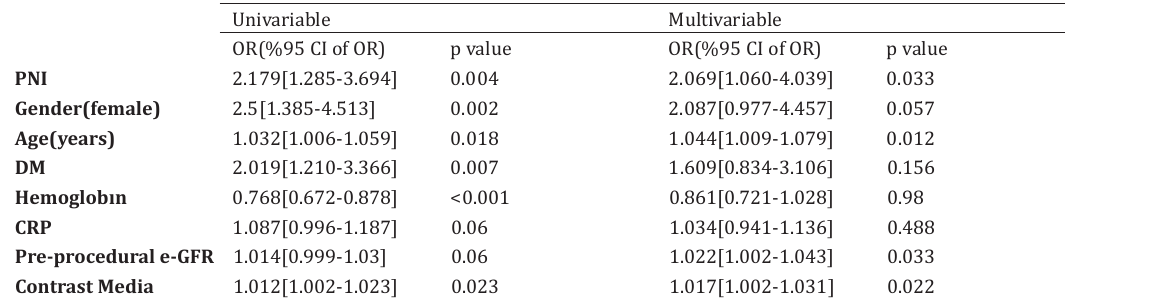
Univariable and multivariable predictors of contrast nephropathy in the study population